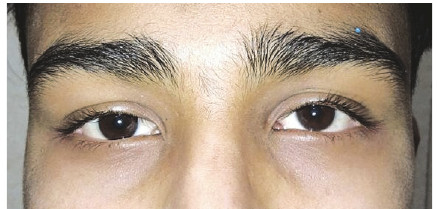
Figure 4: Clinical photograph of patient after 4 weeks of 1mg/kg oral